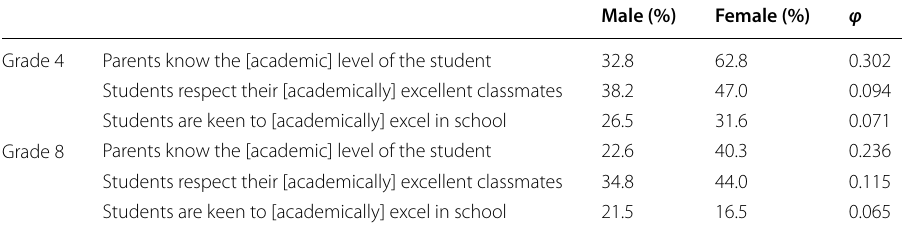
All differences are statistically significant at the .001 level